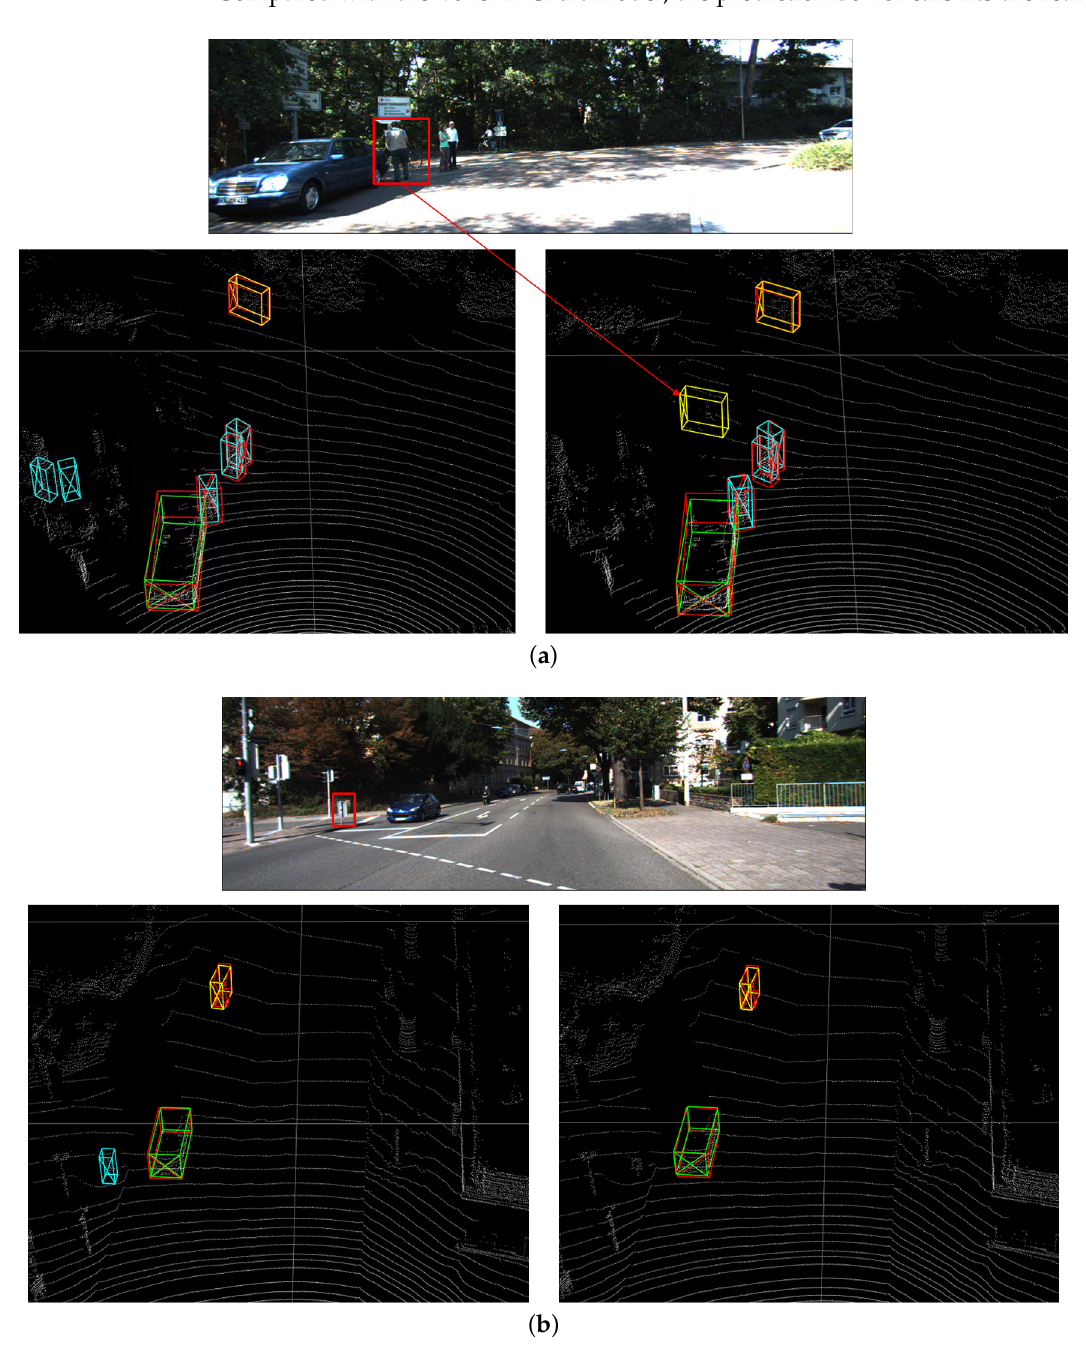
Figure 7. Visualization of 3D object detection result produced by Voxel R-CNN and the method proposed by this paper. The red box represents the ground truth box of the object, the green box represents the detection result of the car, and the blue and yellow represent the detection result of the pedestrian and the cyclist. ( a ) Detection results in obscured scenes. ( b ) Detection results in a simple traffic